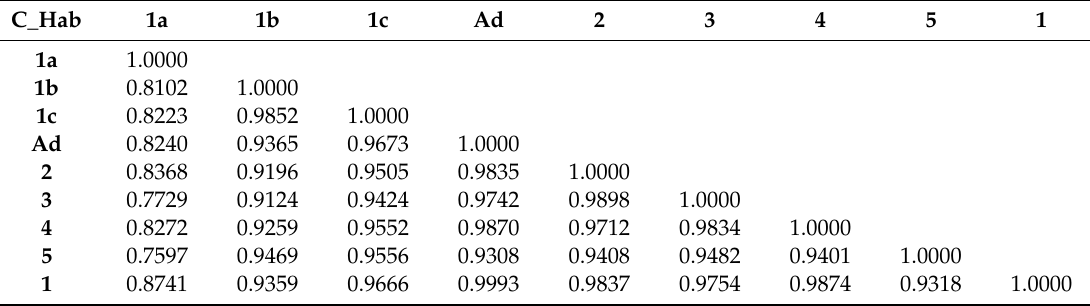
Table 5. Molecular quantum similarity indices using the coulomb operator according to Equation